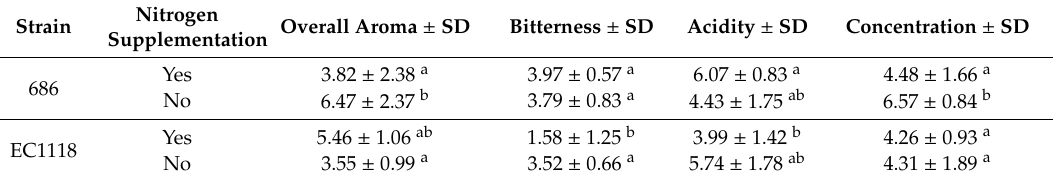
Table 5. Values obtained for descriptive sensory attributes of Malbec wines at pilot scale. Strain